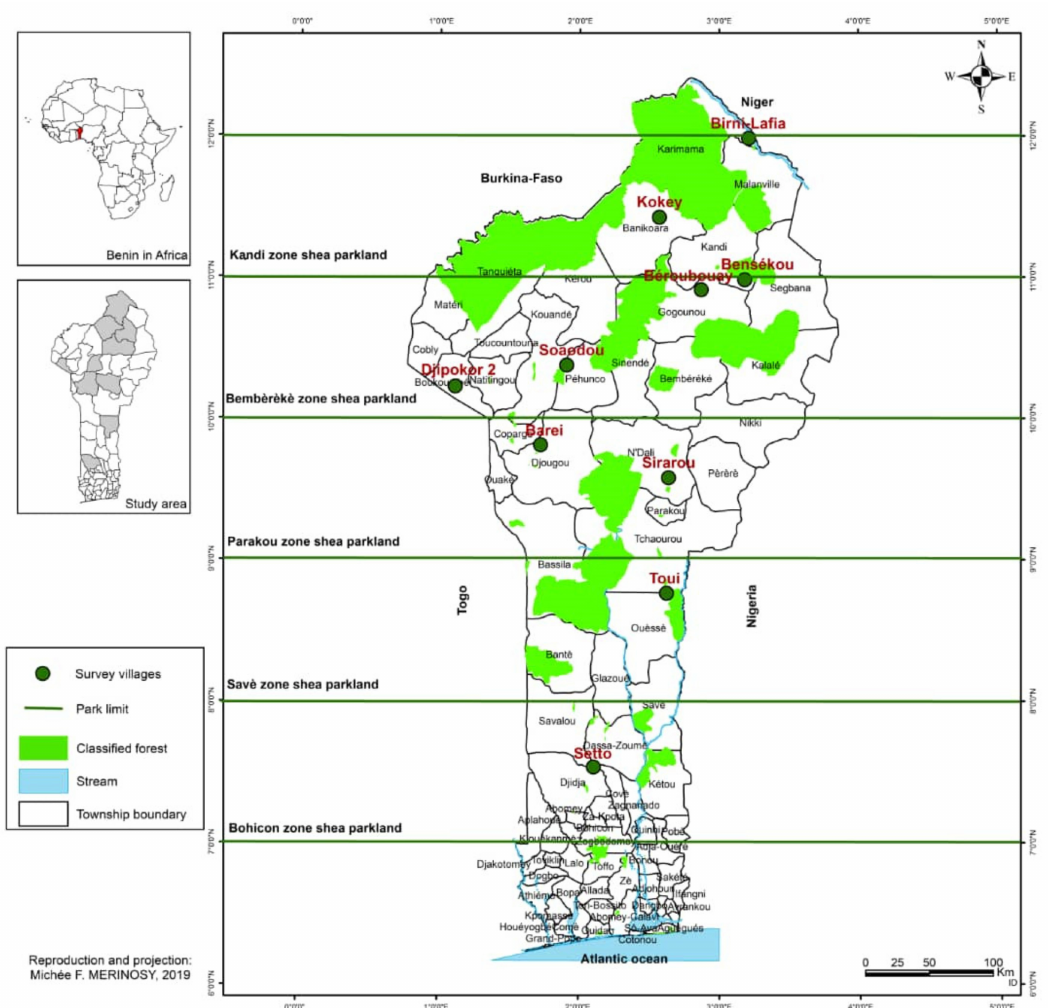
Figure 6. Surveyed areas across shea parks in Benin and major sociolinguistic groups (in brown